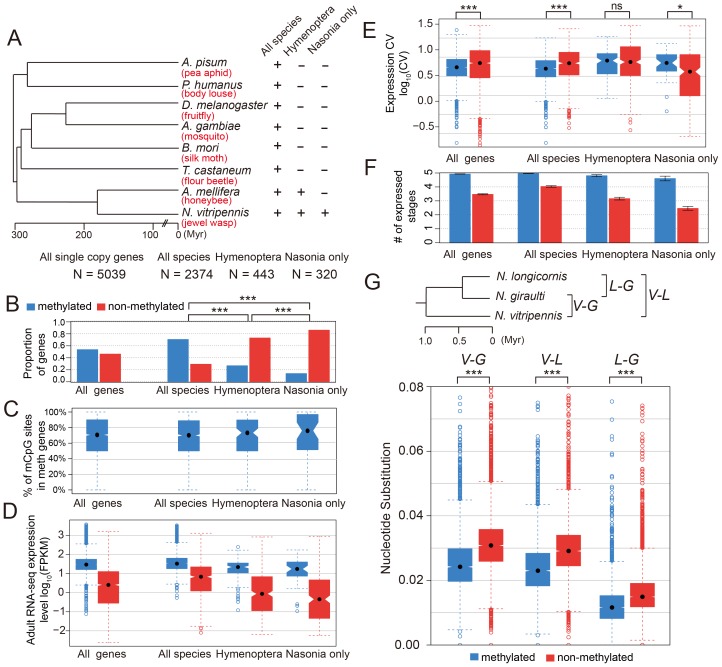
DNA methylation and gene conservation.(A) Phylogenetic tree of eight insect species: Nasonia vitripennis, Apis mellifera, Tribolium castaneum, Bombyx mori, Anopheles gambiae, Drosophila melanogaster, Pediculus humanus and Acyrthosiphon pisum. The methylation status and correlating factors were plotted in (B–F) for four groups of genes: all 5,039 Nasonia single-copy genes with one or zero ortholog in seven other insect species, 2,374 genes with one orthologs in all eight insect species, 443 genes with one orthologs in Apis and Nasonia but missing in other six species, and 320 genes present only in Nasonia. The y-axes plotted in (B–F) are (B): proportion of methylated (blue) and non-methylated genes (red); (C): percentage of methylated CpG sites in methylated genes; (D): adult RNA-seq expression levels (log10FPKM); (E): coefficient of variation of expression level in tiling array across six developmental stages; (F): number of expressed tissues. (G) Top: Phylogenetic tree of three Nasonia species: N. longicornis (L), N. giraulti (G) and N. vitripennis (V). Bottom: boxplots of nucleotide substitution rates between V–L, V–G and L–G.